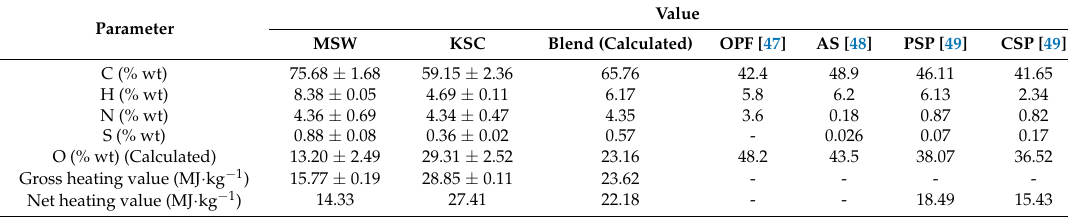
Table 7. Ultimate analysis results for MSW and kernel shell charcoal